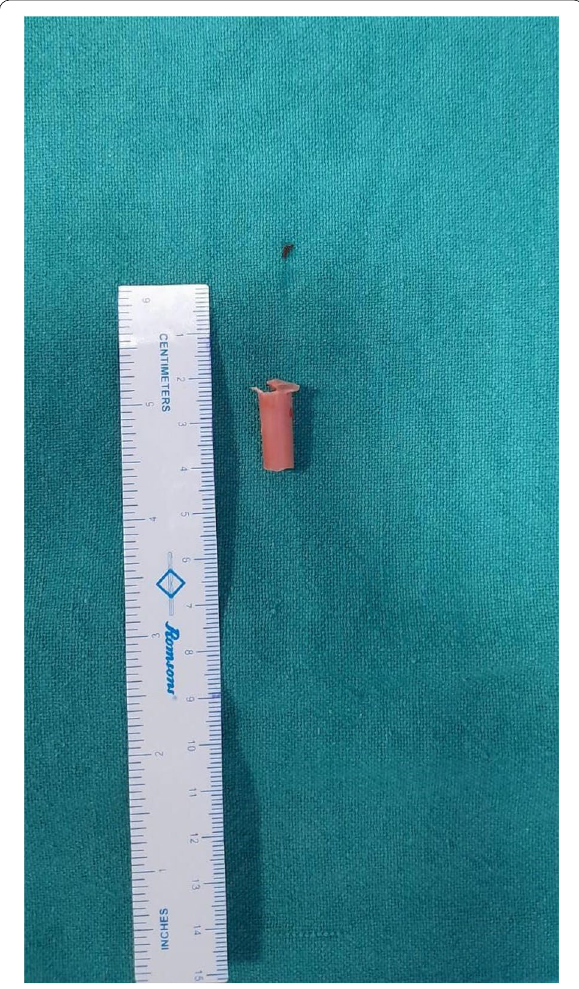
Fig. 2 Removed foreign body